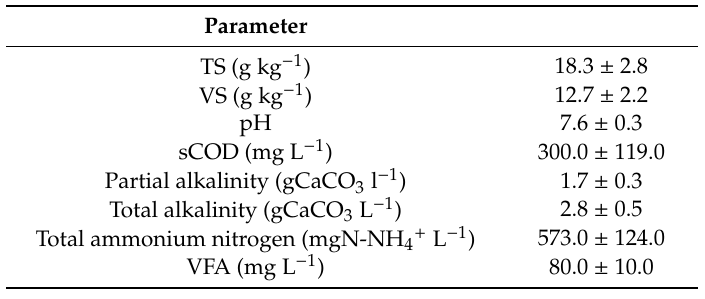
Table 1. Organic fraction of municipal solid waste and waste activated sludge (OFMSW-WAS) digestate characterization ( n =